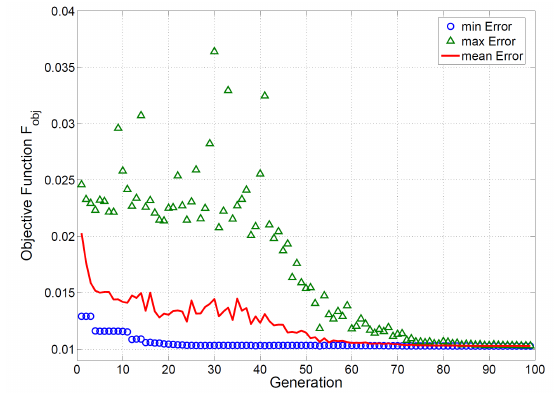
Figure 6. The evolution of the genetic algorithm for finding the optimized binary code